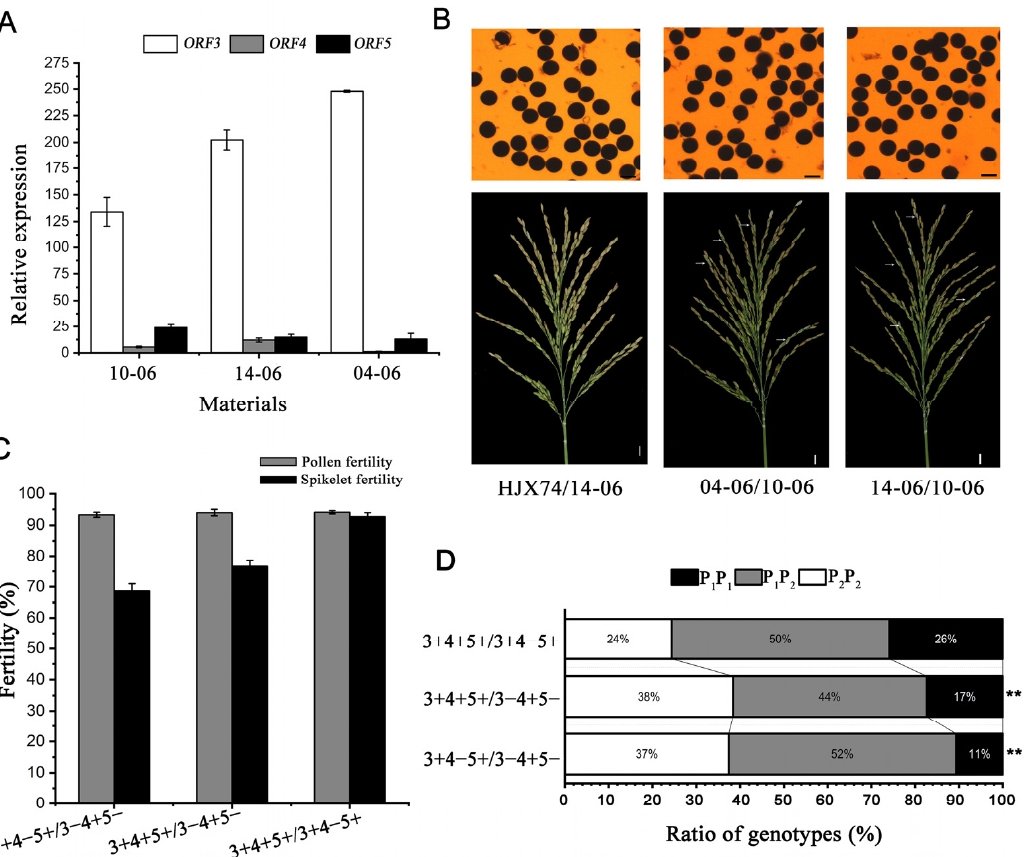
Figure 2. Genotypes and genetic effects of three genes at the S5 locus in HJX74 SSSLs ( A ) Expression level of three adjacent genes at S5 locus in young panicles of three SSSLs. The reference gene was Profilin. ( B ) Pollen grains stained by I 2 -KI solution (top) and spikelet fertility in the panicles (bottom) in F 1 hybrids. Scale bar in pollen grains, 30 µ m. Scale bar in panicles, 1 cm. The arrow points to the empty grain. ( C ) Pollen fertility and spikelet fertility in hybrids F 1 from the crosses of the SSSLs carrying the S5 gene in different genotypes. ORF3 , ORF4, and ORF5 were abbreviated as “3”, “4”, and “5”. Error bars represent SD, n = 10. ( D ) The ratio of genotypes at the S5 locus in the F 2 populations from the crosses of SSSLs with S5 gene and testers. P 1 P 1 , Genotype of the left SSSL. P 1 P 2 , Heterozygous genotypes. P 2 P 2 , Genotypes of the right SSSL. **, significantly different at 0.01 probability level.